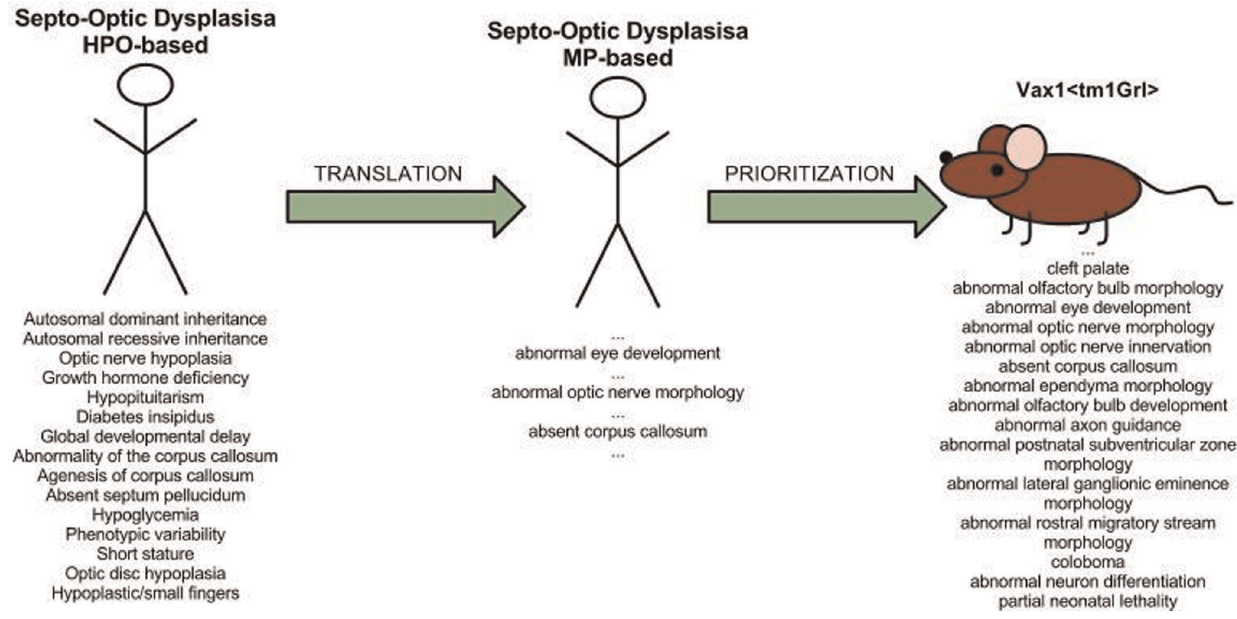
Figure 5. Vax1 is one of the highest ranked mouse model for Septo-Optic Dysplasia. After combining both lexical and ontological mapping (illustrated in Figure 2), human diseases were ‘‘translated’’ with the combined mapping to an MP representation (results with highest AUC score). We manually verified some of the MP-based prioritization results (including Septo-Optic Dysplasia). The figure illustrates the original annotation for the disease based on HPO and its ‘‘translation’’ to MP. It also includes the annotations contained in MGI for mouse models with the Vax1 v tm1Grl w (MGI:1859863) allele. To reduce the complexity of the figure, we did not include all annotations resulting from the ‘‘translation’’ of the disease annotations and after the enrichment of the mouse model annotations. A full list of all annotations is provided as supplementary material (supplementary file S1), also including other highly ranked mouse models for Septo-Optic Dysplasia. doi:10.1371/journal.pone.0038937.g005 PLoS ONE |